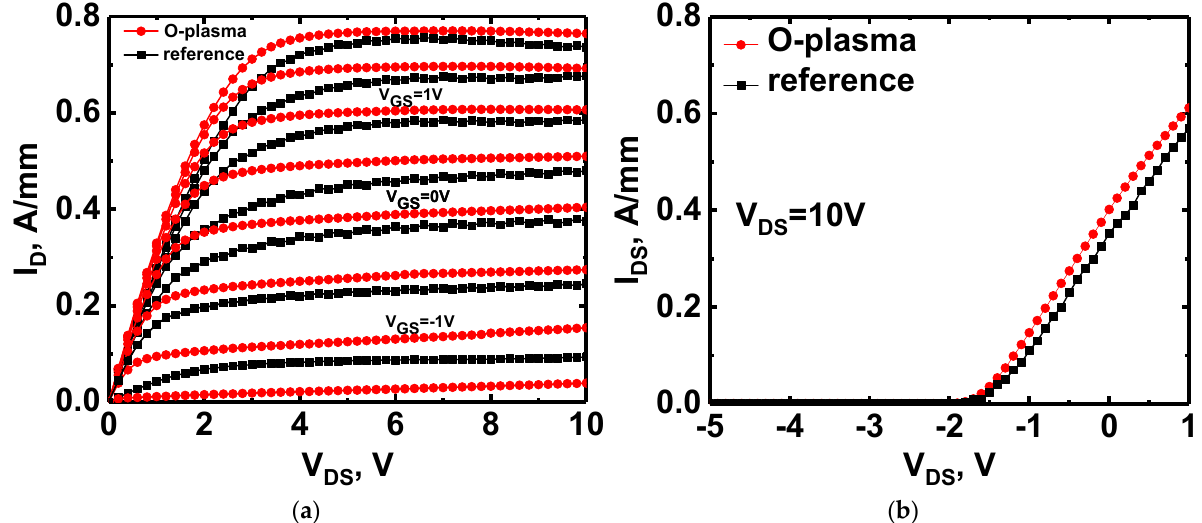
Figure 7. Impact of inductively coupled plasma (ICP) power on R C . ( a ) R C with different ICP power and ( b ) I–V characteristic curve of different ICP power.